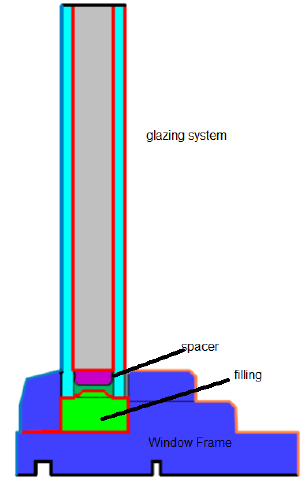
Figure 1. Schematic of the designed window frame with double glazing